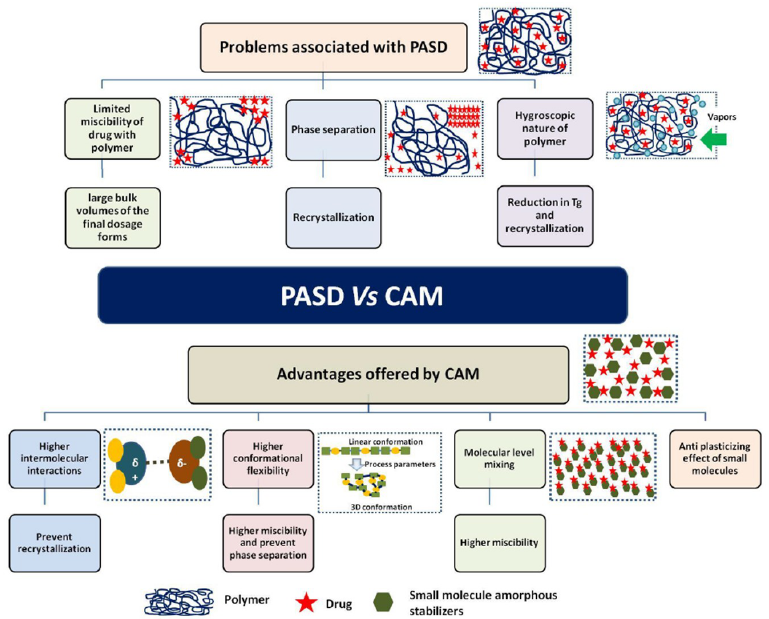
Figure 3. Advantages of co-amorphous systems (CAM) over polymeric amorphous solid dispersions (PASD) [23].